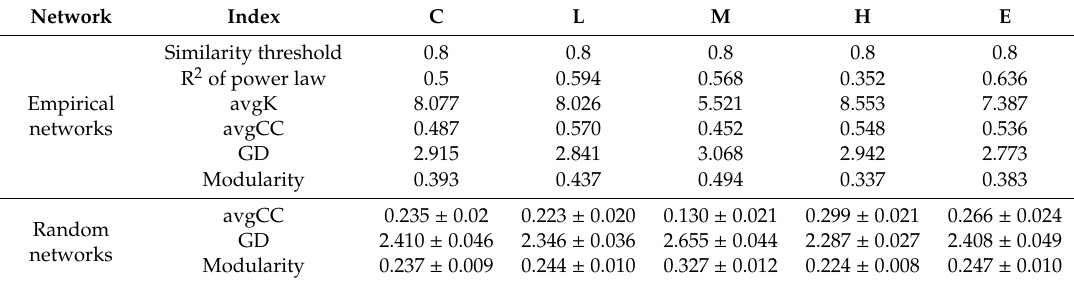
Table 1. Topological properties of the empirical molecular ecological networks of microbial communities and their random networks under five CO 2 concentrations. (C, control; L, low CO 2 concentration; M, medium CO 2 concentration; H, high CO 2 concentration; E, extreme CO 2 concentration).